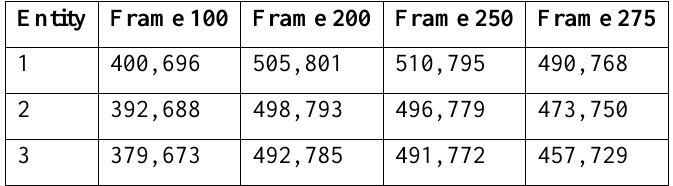
Table 6 Experimental result table of physical pixel distance of track